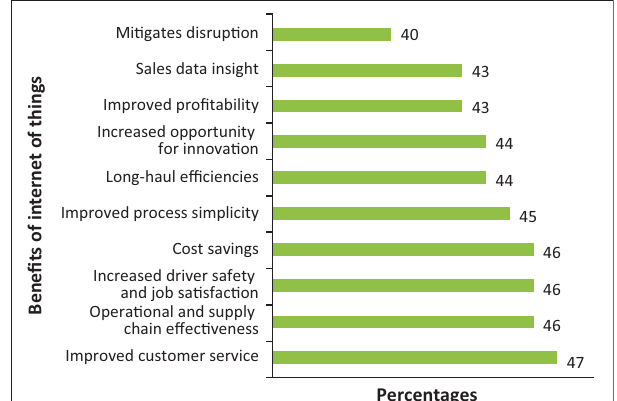
FIGURE 4: Effects of implementing internet of things.